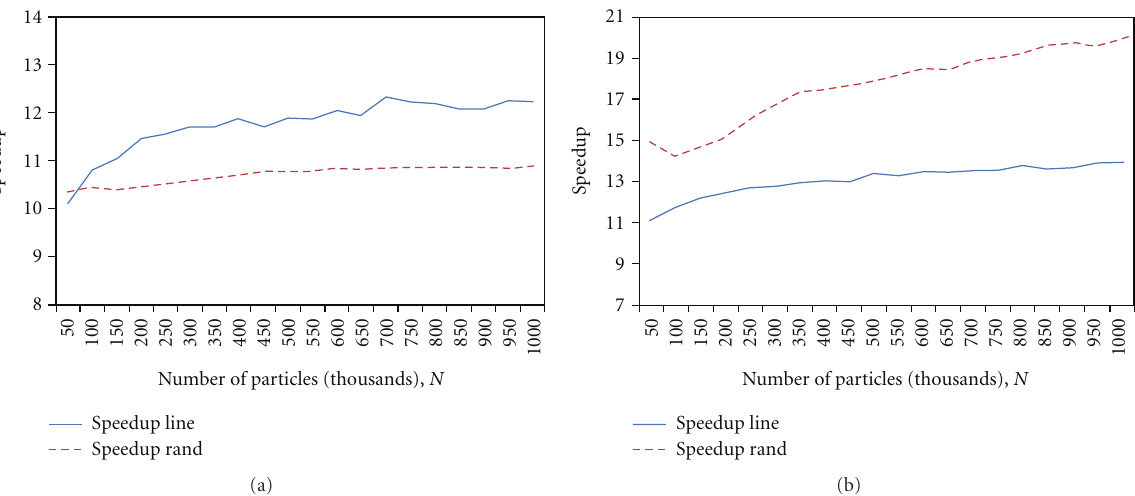
Figure 7: 2D (a) and 3D (b) Barnes-Hut application speedup achieved by the traversal cache framework on a Virtex 4 LX100 compared to a 3.2 GHz Xeon for various numbers of particles and representative distributions. The speedup is larger for the 3D algorithm, despite approximately equal similarity for each distribution, indicating that the increased computational intensity of the 3D algorithm takes better advantage of the FPGAs resources. Theta = 0.5.